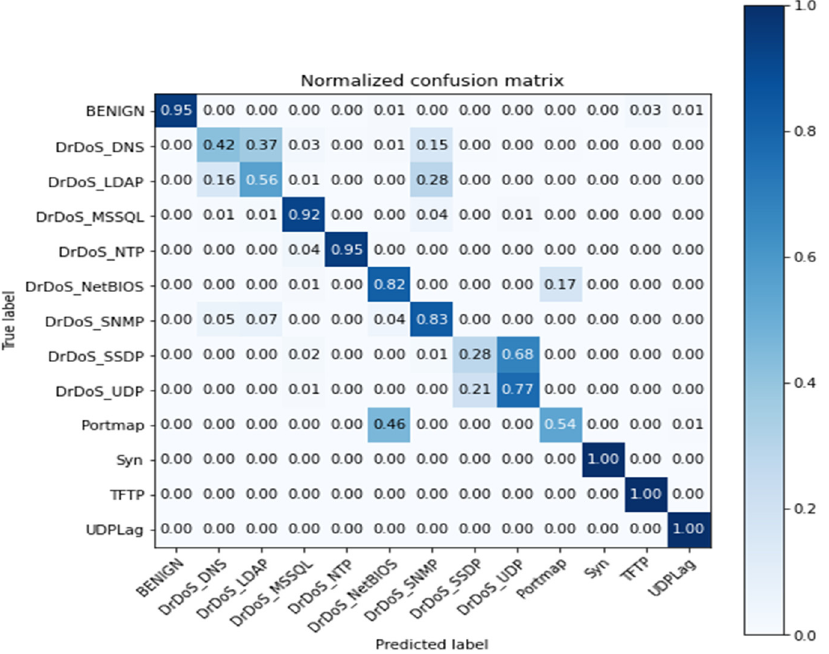
Figure 3. Confusion matrix for the first scenario.